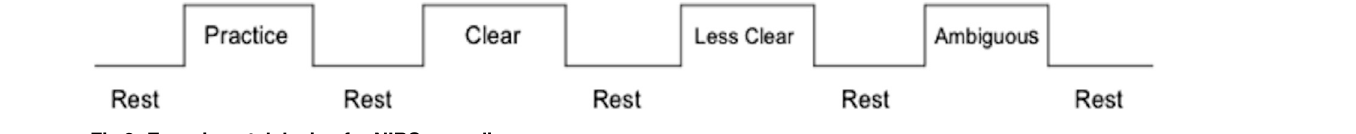
Fig 2. Experimental design for NIRS